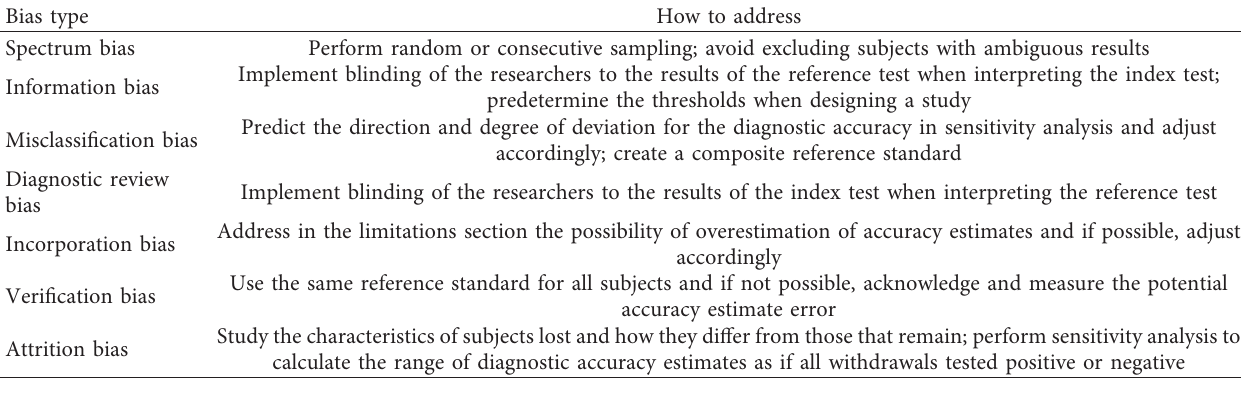
Table 1: Types of bias in diagnostic accuracy studies and how to address them.